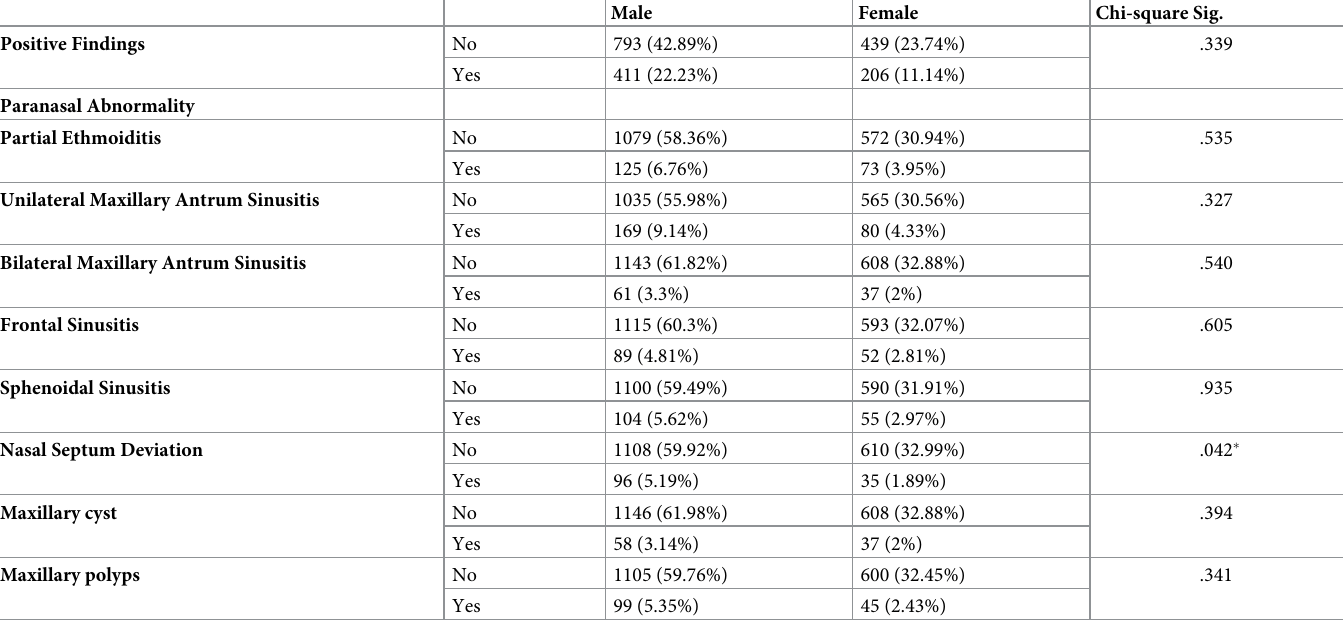
Table 2. Shows an association between gender and the types of paranasal sinusitis. It represents the frequency (%), and yes/no indicates the presence/absence of the abnormality. For the positive findings section, the patient was considered positive if he/she expressed one or more abnormalities. Male Female Chi-square Sig.